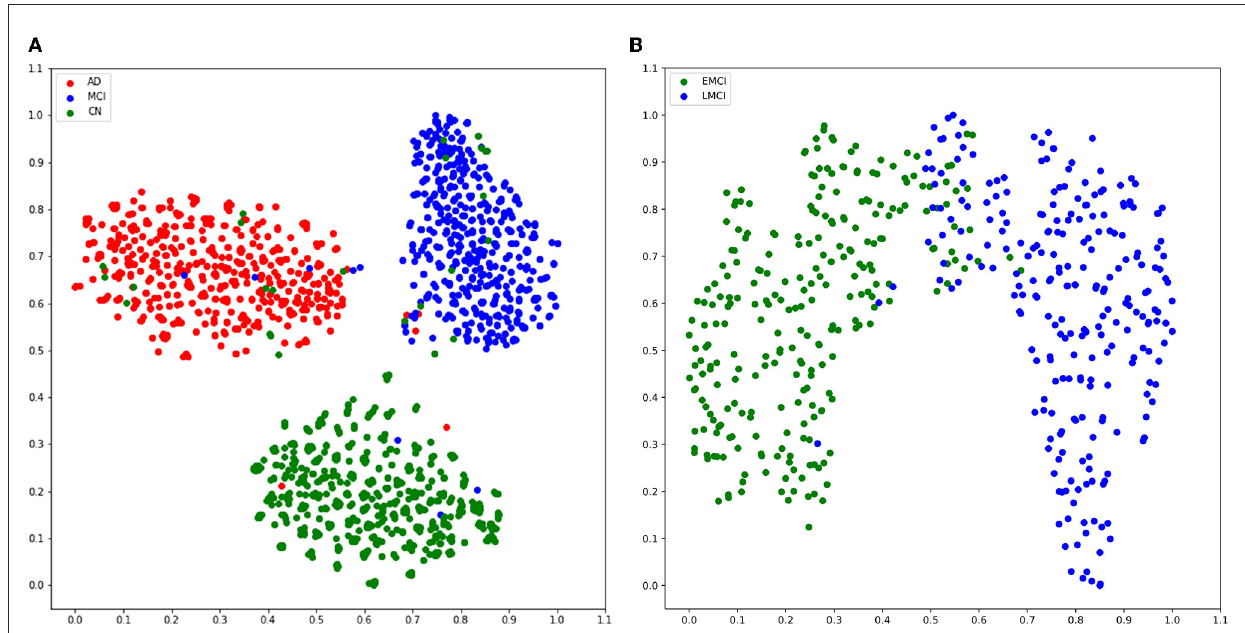
FIGURE5 Scatter plot of all data after dimension reduction by t-SNE. (A) Visualization of dimension reduction for AD, MCI, and CN. (B) Visualization of dimension reduction for EMCI and LMCI.